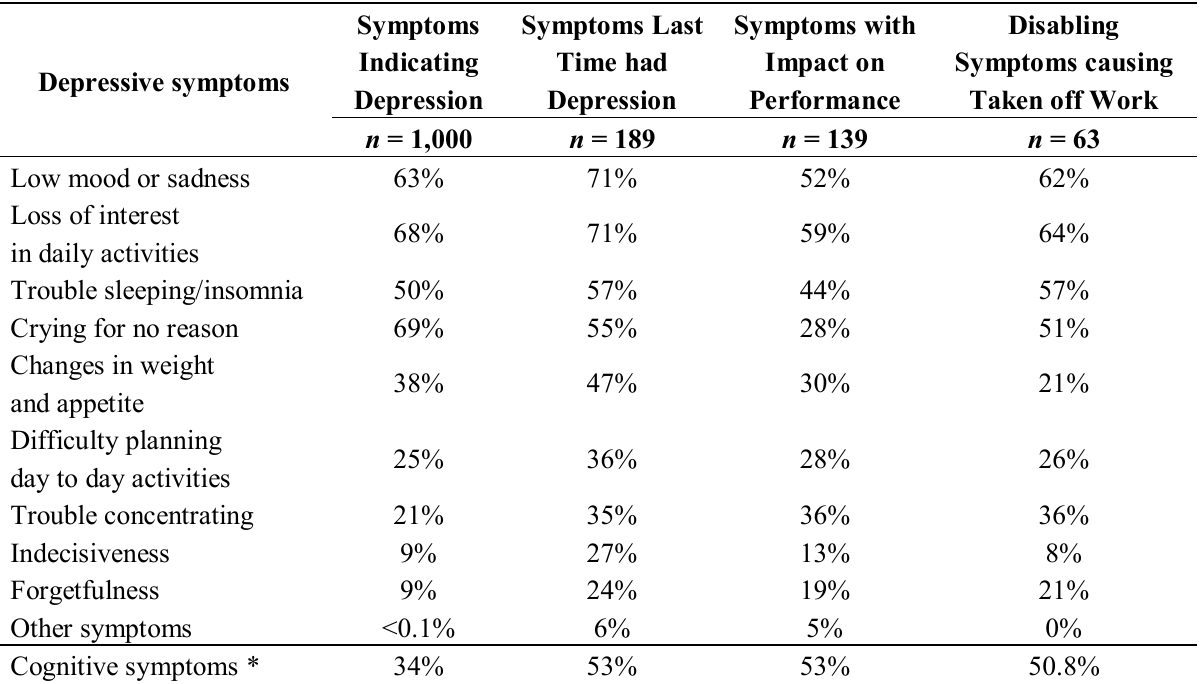
Table 2. Common depressive symptoms as described by all workers ( n = 1000); in the most recent episode; with impact on work performance while depressed; and which caused taken off work.